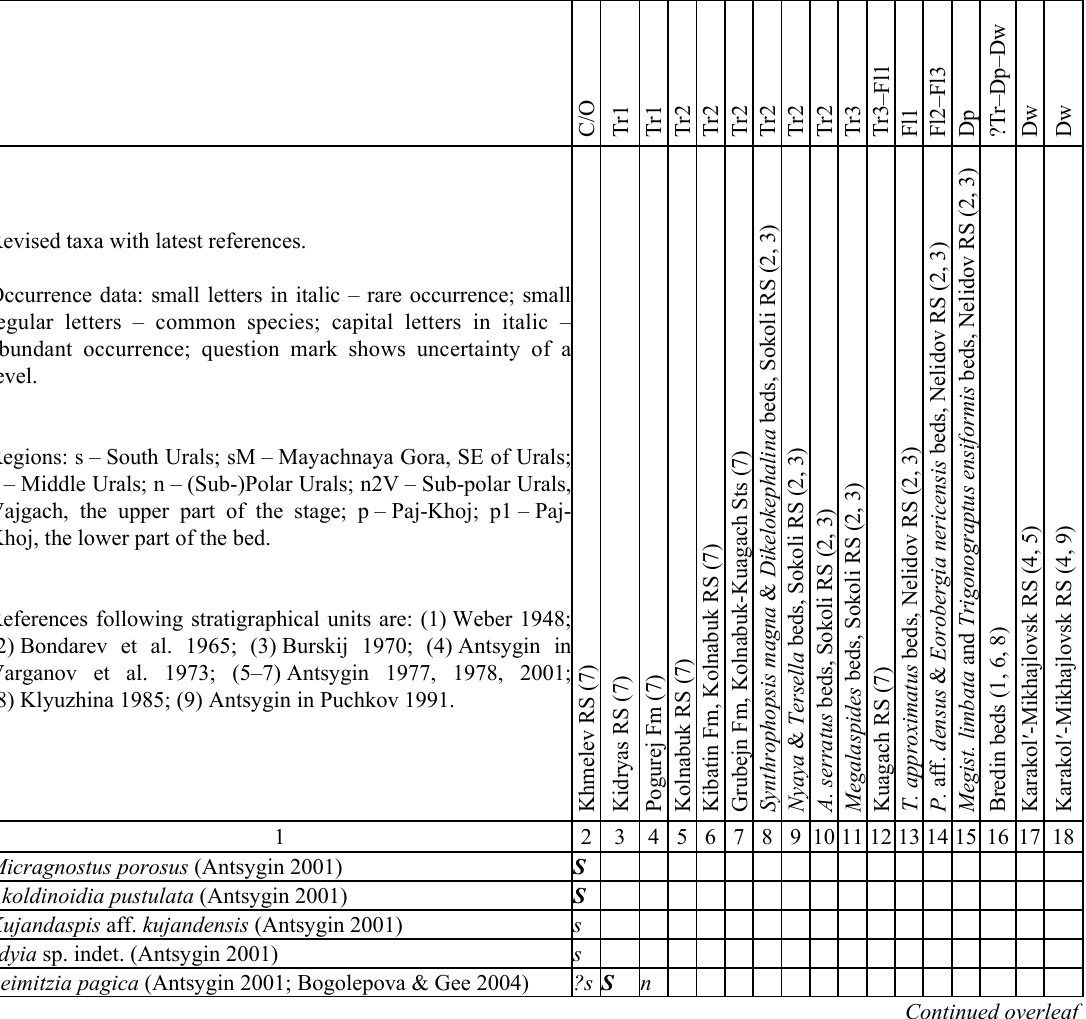
Table 2. List of trilobite species of the Uralian border of